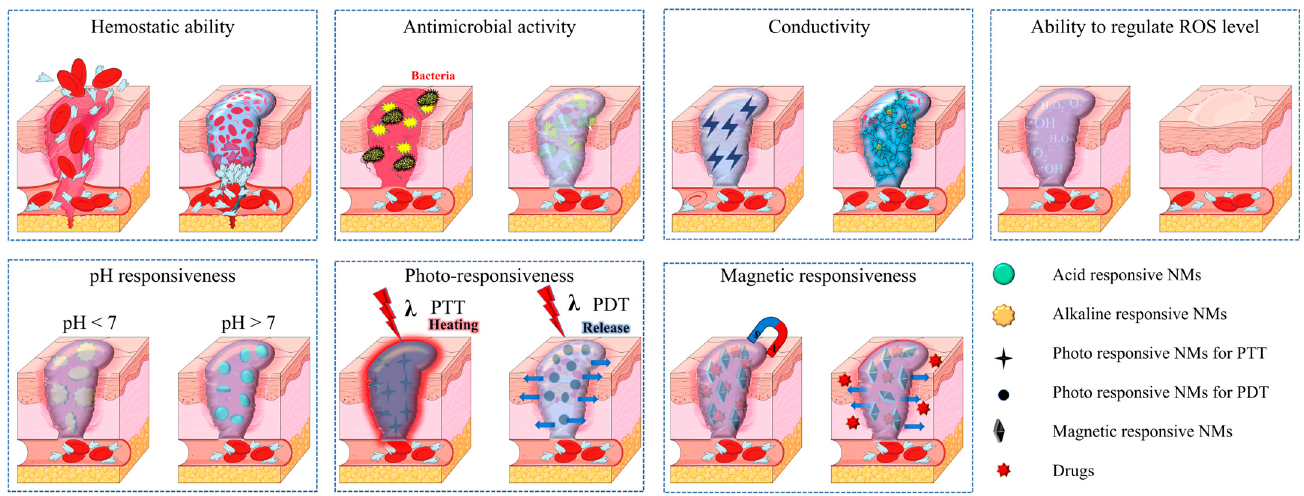
Figure 3. Schematic of functions of NMFHs for the cutaneous wound treatment. (PTT: photothermal therapy; PDT: photodynamic therapy).